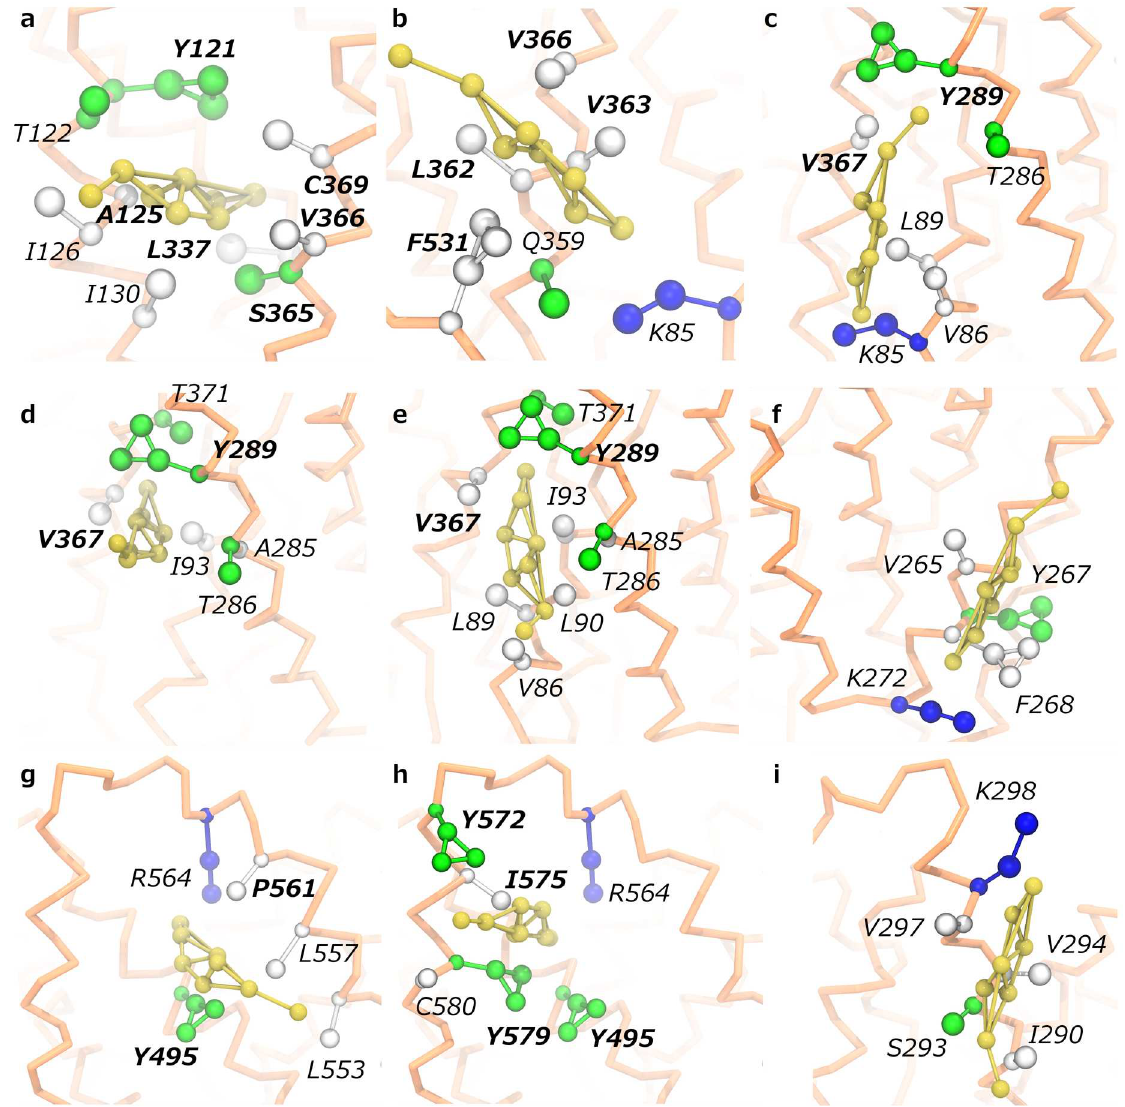
Fig 4. Focus on cholesterol interaction sites. (a-i) Coarse-grainedrepresentation of SERT residues (CPK representation; coloringscheme: apolar/aromatic: white; polar/aromatic: green; blue: basic) forming the six sites and interacting with a cholesterol molecule(yellowCPK representation) in all the observedbindingmodes (see text) are shown. ( a ): Site K; ( b ): Site S; ( c ): Site C, bindingmode 1; ( d ): Site C, bindingmode 2; ( e ): Site C, bindingmode 3; ( f ): Site L4; ( g ): site A, sub-site A1; ( h ): Site A, sub-site A2; ( i ): Site A, sub-site A2. The sixteen outlier residues are labeledin